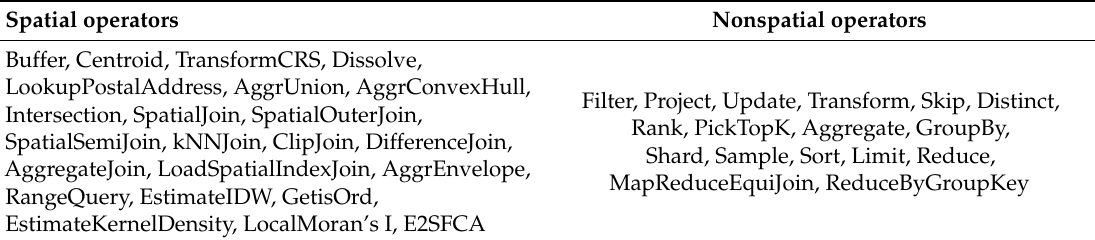
Table 1. Spatial and nonspatial operators in RecordSetFuntion supporting in